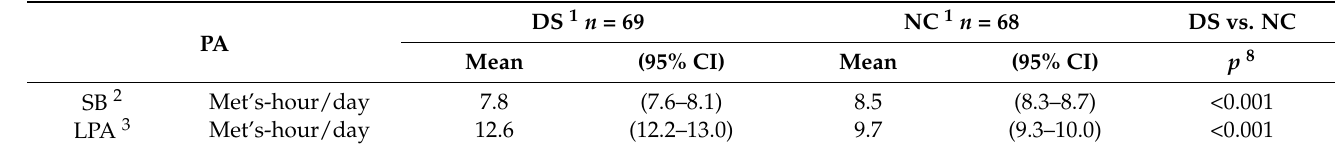
Table 3. The amount of physical activity (Met’s-hour/day) for children with Down syndrome and normal